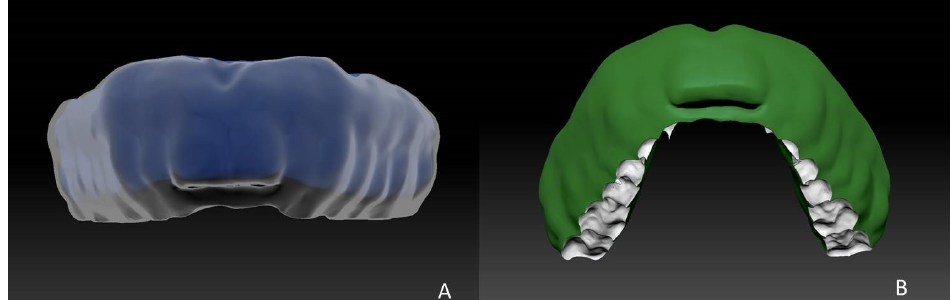
Figure 5. ( A ) Inner layer (blue) and outer layer (transparent) with virtual polishing of the outer surface; ( B ) adaptation of the caudal part to the occlusal surface of the lower jaw and airway creation.